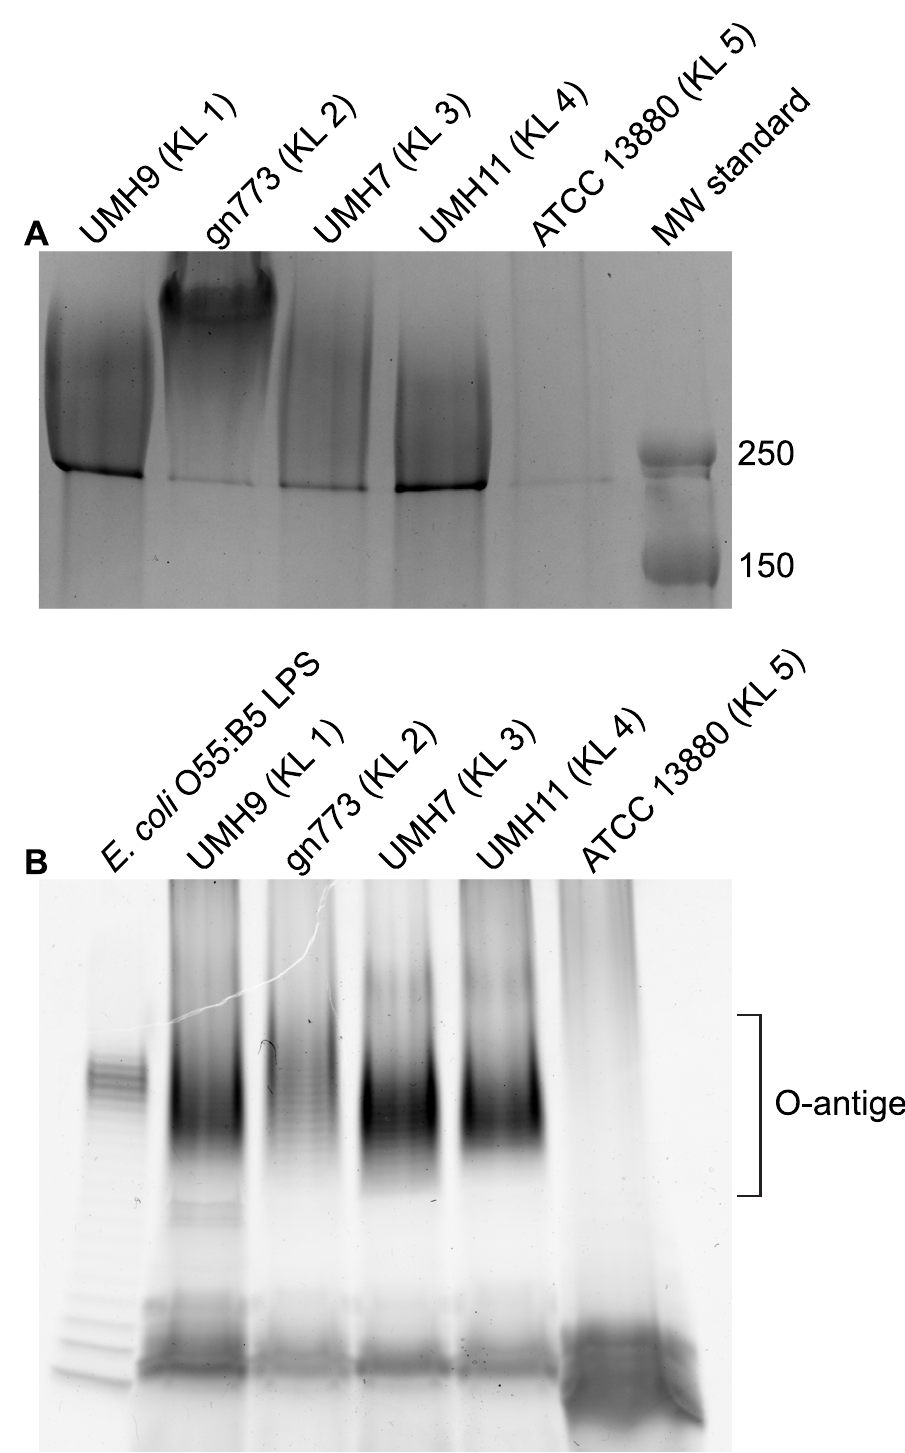
Fig 7. SDS-PAGE of S . marcescens CPS and LPS from five KL clades. Total cell-associated polysaccharides were isolated from S . marcescens strains following overnight culture. (A) Purified polysaccharides were resolved on 7.5% SDS-PAGE gels and visualized by Alcian Blue staining. The molecular weights (kDa) of pre-stained protein standards (MW standard) are indicated. (B) Total cell-associated polysaccharides were also electrophoresed on 4–20% gradient SDS-PAGE gels. LPS was visualized using the Pro-Q Emerald 300 Liposaccharide Gel Stain Kit with purified LPS from E . coli serving as a positive control. The region containing the characteristic O-antigen laddering pattern is indicated.